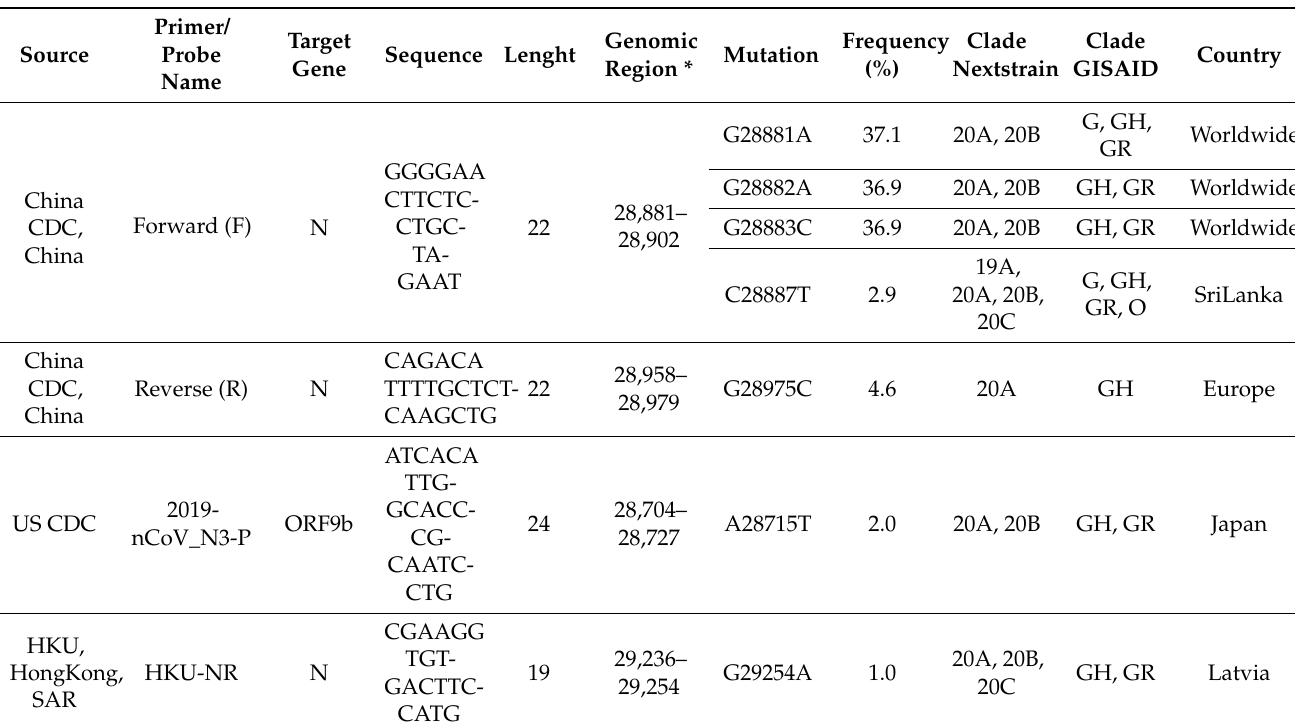
Table 5. Summary of mismatches between publicly available RT-PCR primers/probes and SARS-CoV-2 genomes analyzed in this study.